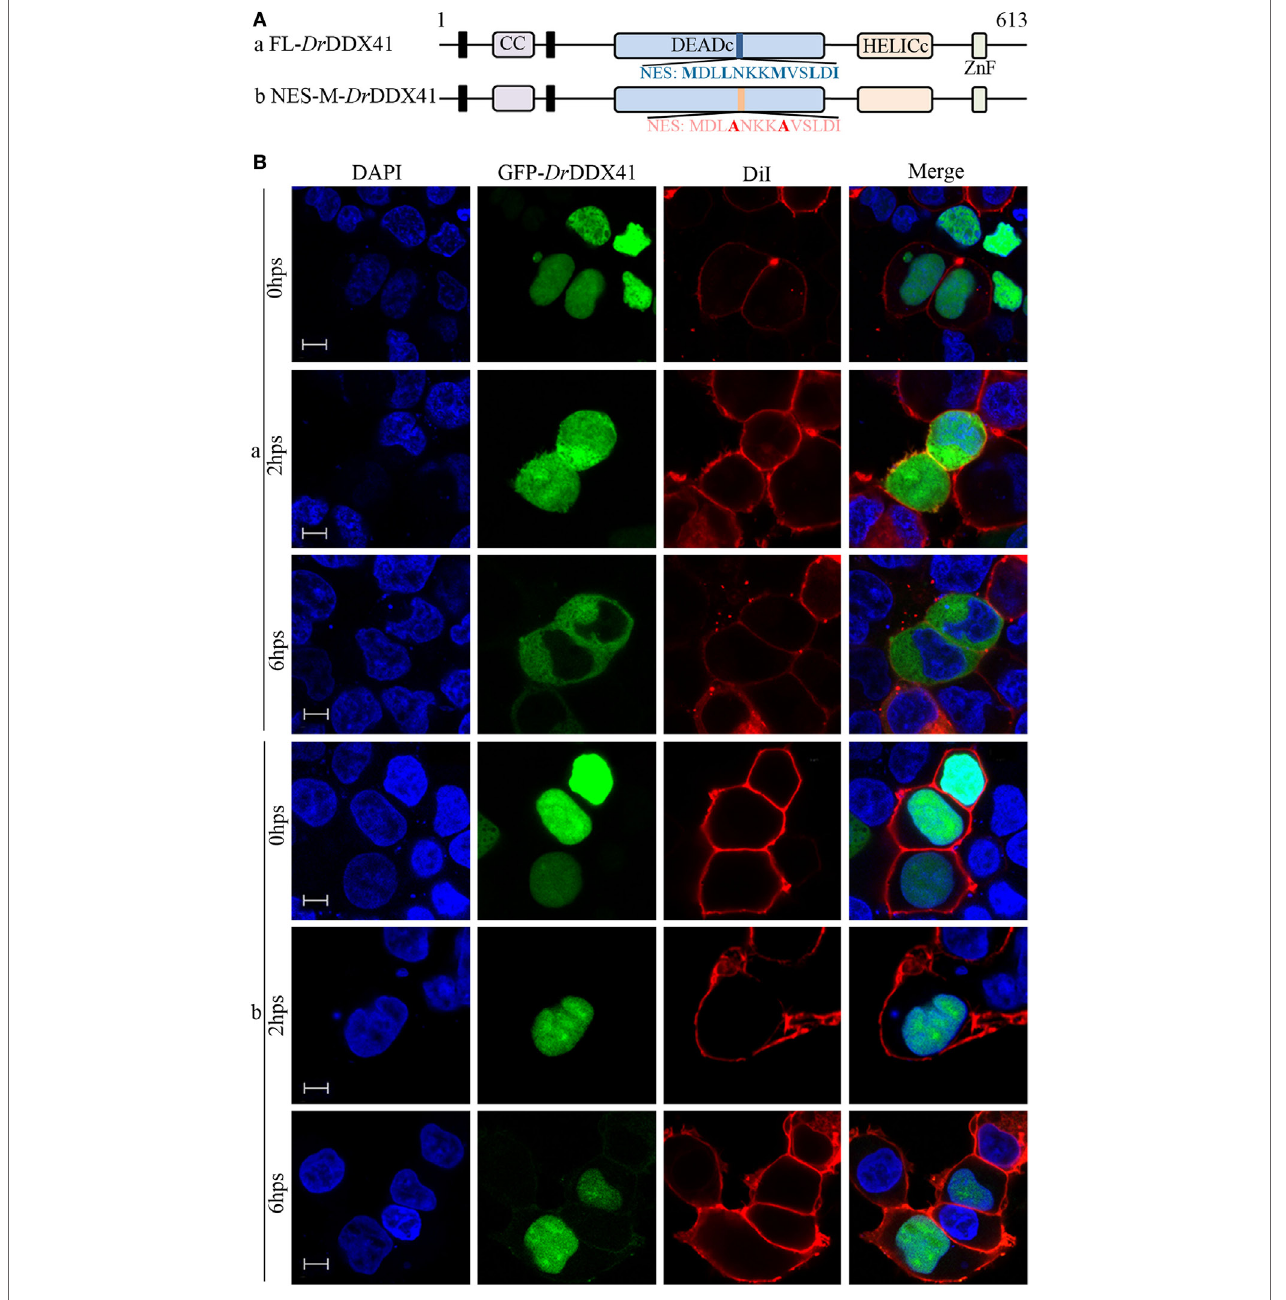
FigUre 5 | Trafficking analysis of Danio rerio DDX41 ( Dr DDX41) and identification of the nuclear export signal (NES) motif within it. (a) Schematic diagram of full-length and the NES-mutated Dr DDX41. (B) Trafficking of Dr DDX41 in response to poly(dA:dT) stimulation at different hours post stimulation (hps) and the contribution of NES motif to the trafficking. Stimulation with poly(dA:dT) induced transportation of Dr DDX41 (full-length, a) from nucleus to cytoplasm. Meanwhile, the NES-like-mutant Dr DDX41 (NES-M, b) remained in the nucleus without any response to poly(dA:dT) stimulation. Scale bars represent 5 µm. Images were captured under a laser-scanning confocal microscope (Zeiss LSM-710; original magnification, 630 ×